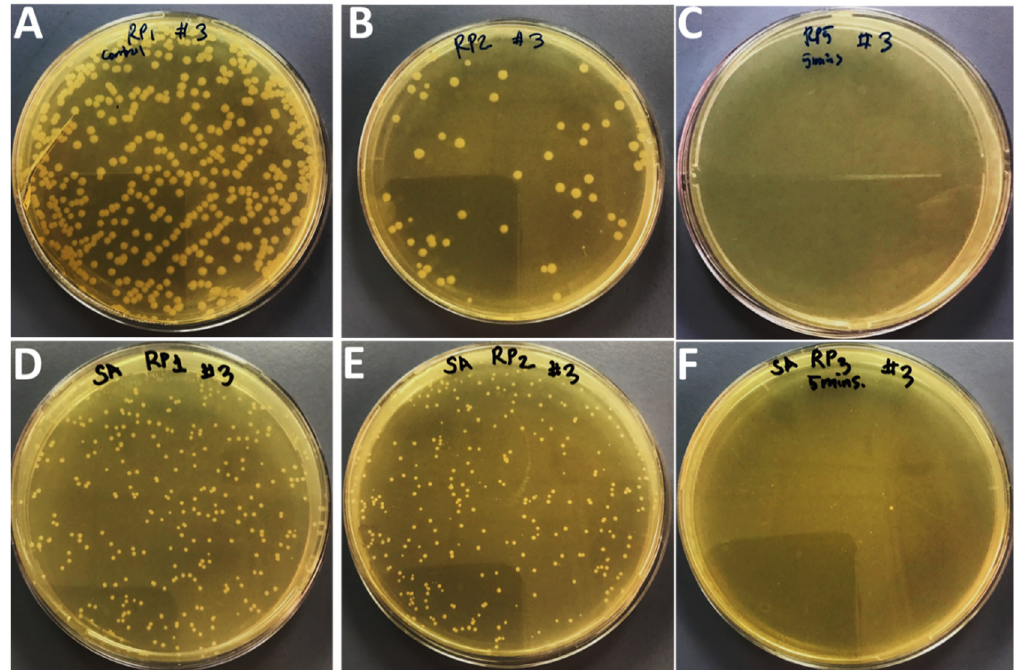
Figure 8. Effects of Ag-Ag 3 PO 4 on the growth of E. coli ( A – C ) and S. aureus ( D – F ). ( A , D ); without compound and without sonication, ( B , E ) with compound but without sonication, and ( C , F ); with compound and 5 min of sonication.